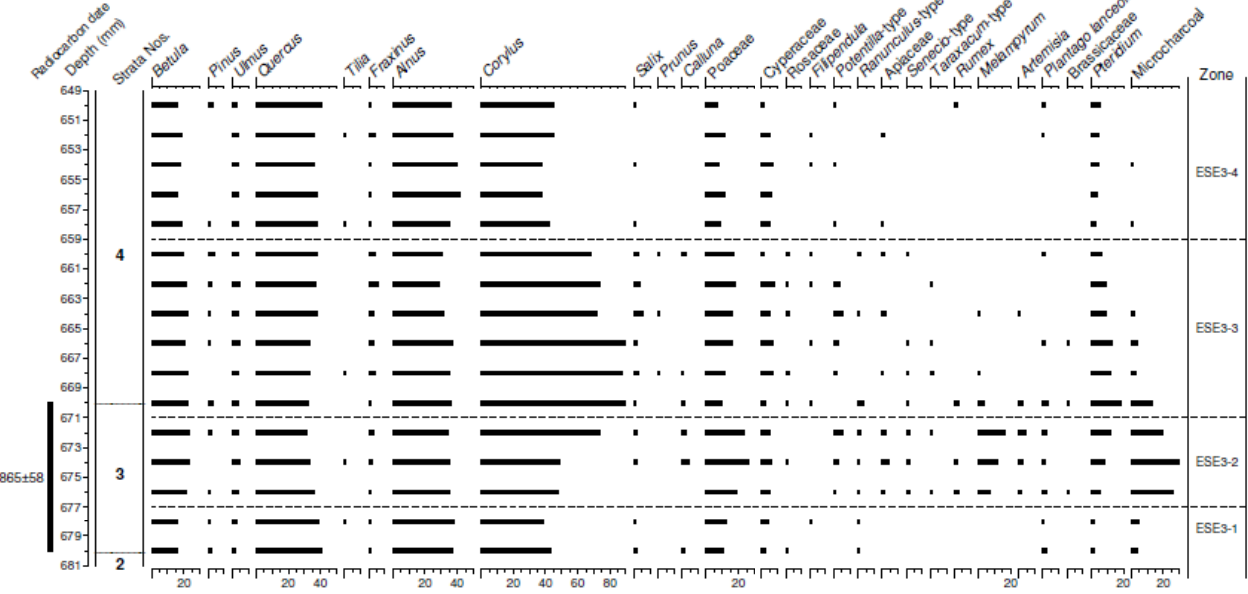
Figure 3. Selected taxa pollen diagram through a Mesolithic age disturbance phase at Little Hawes Water. Frequencies are calculated as percentages of total tree pollen, which comprises Betula to Alnus on the diagram.